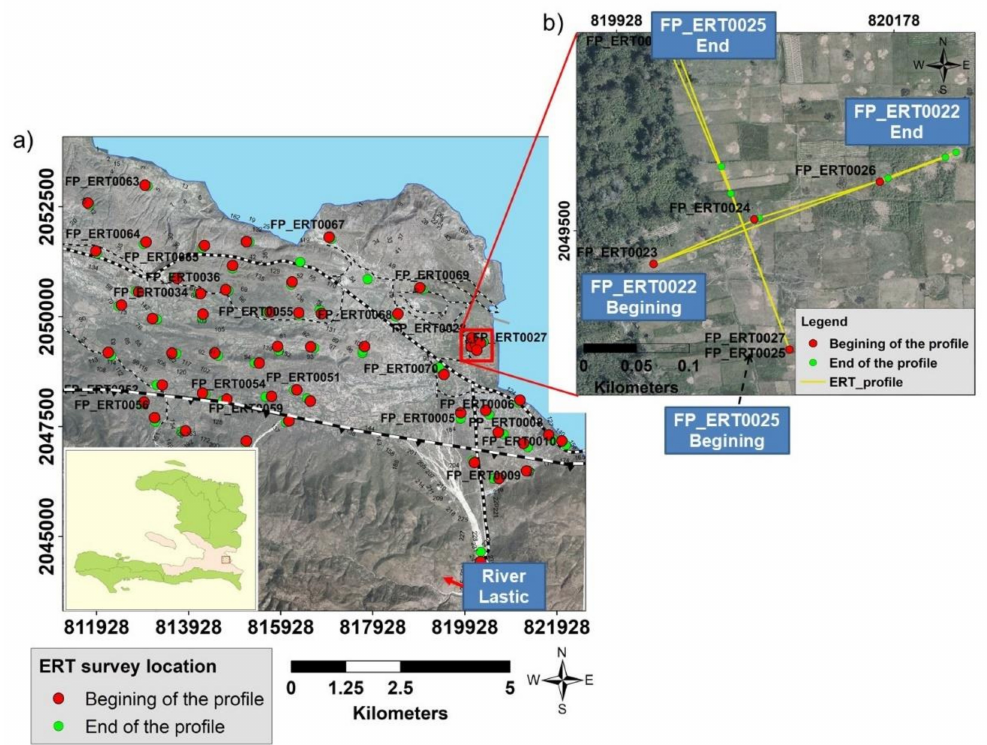
Figure 2. ( a ) Location of the Electrical Resistivity Tomography (ERT) profiles in Fond Parisien, with black roughly E-W trending outline of EPGF (middle part of the map), and the three zones of investigation (La Source village and valley to the South in blue, central sedimentary basin in green and western part, on harder grounds, in red). ( b ) Detailed map of dense ERT measurements on soft soils in the NW of “La Source”